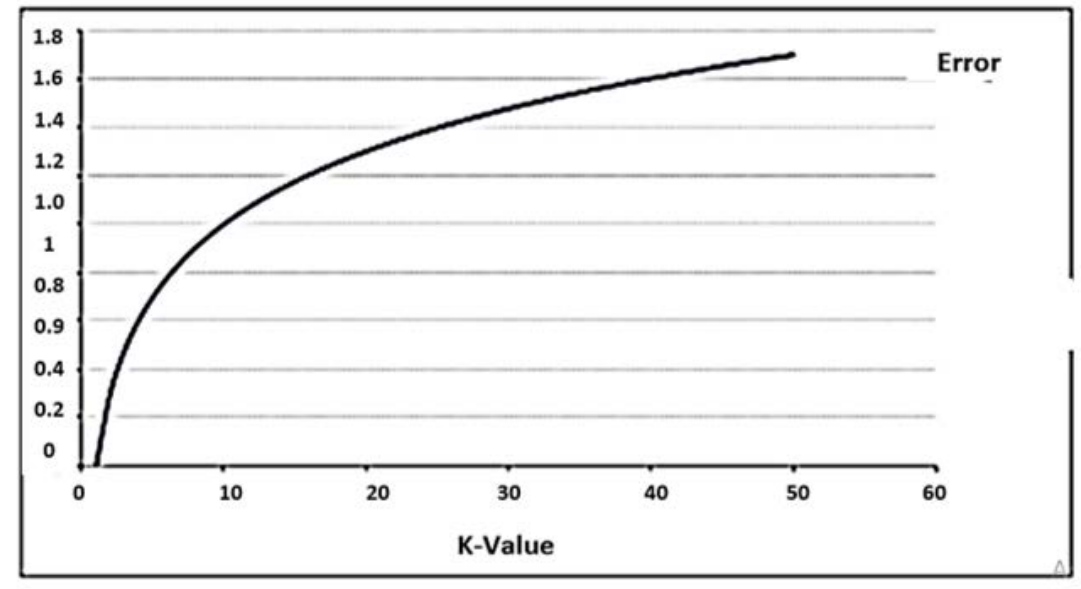
Figure 11. The curve for the training error rate with a varying value of